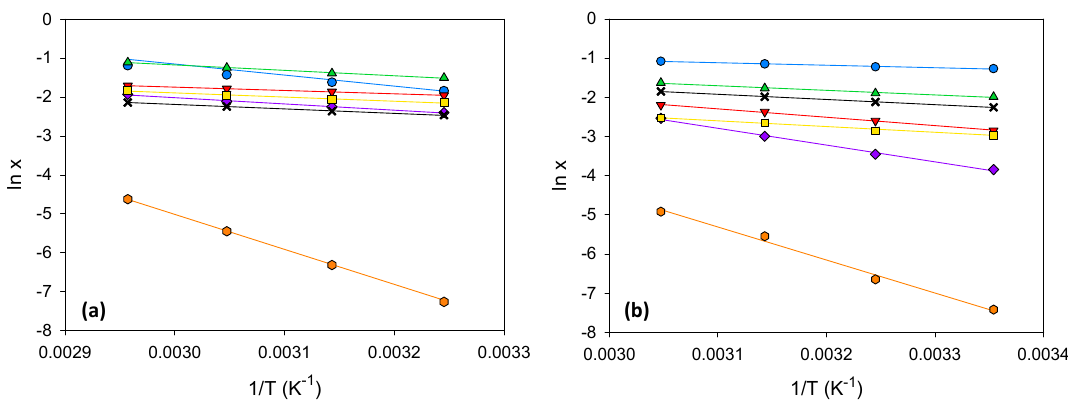
Figure 4. Experimental solubility data correlated by the van ‘t Hoff equation for different amino acids in the eutectic solvent ( a ) and in its 50:50 (wt:wt) mixture with water ( b ). Legend: glycine; β -alanine; L-proline; trans-4-hydroxy-L-proline; L-lysine·HCl; L-arginine; L-cystine.